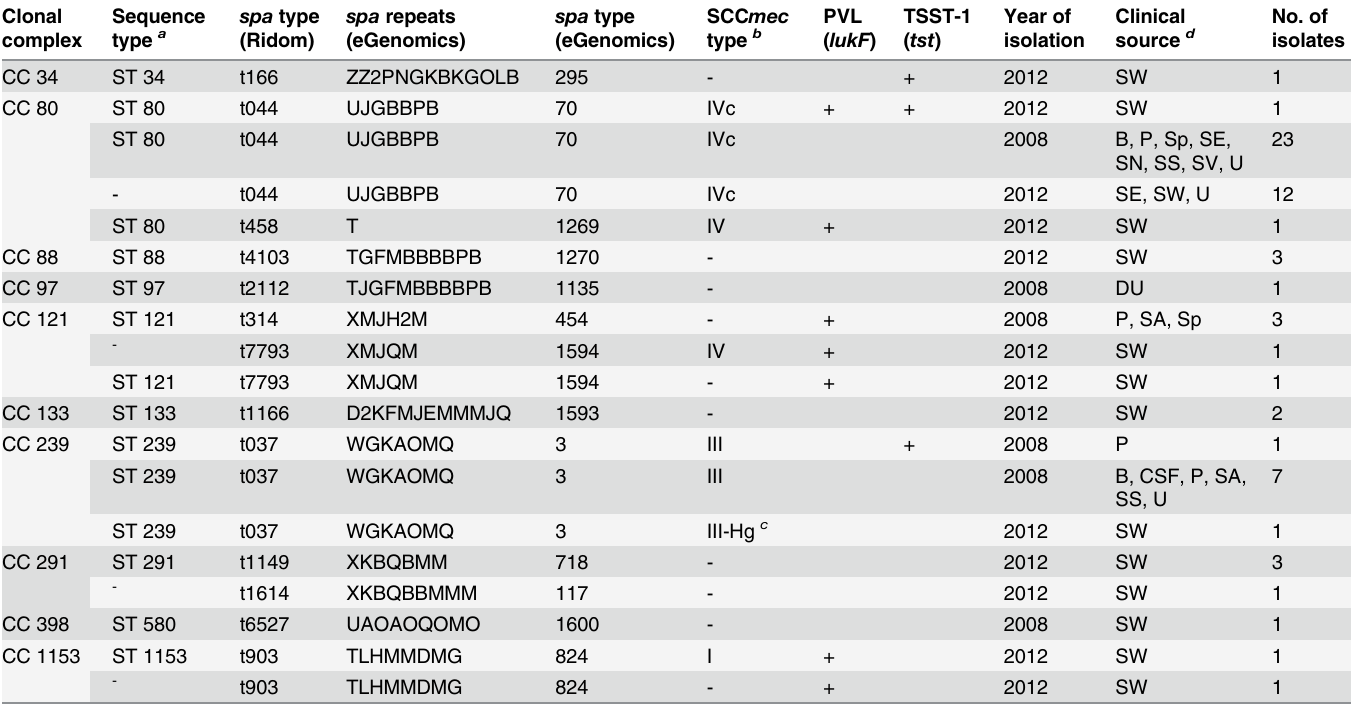
value appears, only one isolate was chosen, regardless of the number of isolates listed in the fi nal column. A dash (-) indicates that MLST was not performed. b A dash (-) indicates that no SCC mec targets were detected, and the strain is methicillin-susceptible (MSSA). c “ III-Hg ” refers to SCC mec type III with SCC mercury ( ccrC ). d Clinical isolate sources are abbreviated as follows: B, blood; CSF, cerebrospinal fl uid; DN, nipple discharge; DU, urethral discharge; DV, vaginal discharge; P, pus; S, semen; Sp, sputum; SA, abscess swab; SE, ear swab; SN, nasal swab; SS, skin swab; SU, umbilical swab; SV, vaginal swab; SW, wound